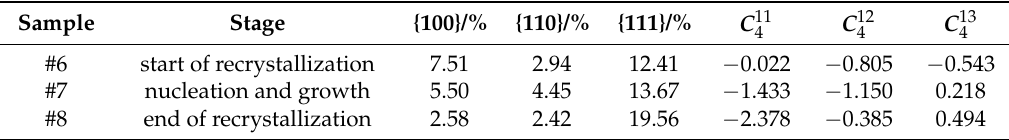
Evolution of texture volume fraction and fourth order texture coefficients during